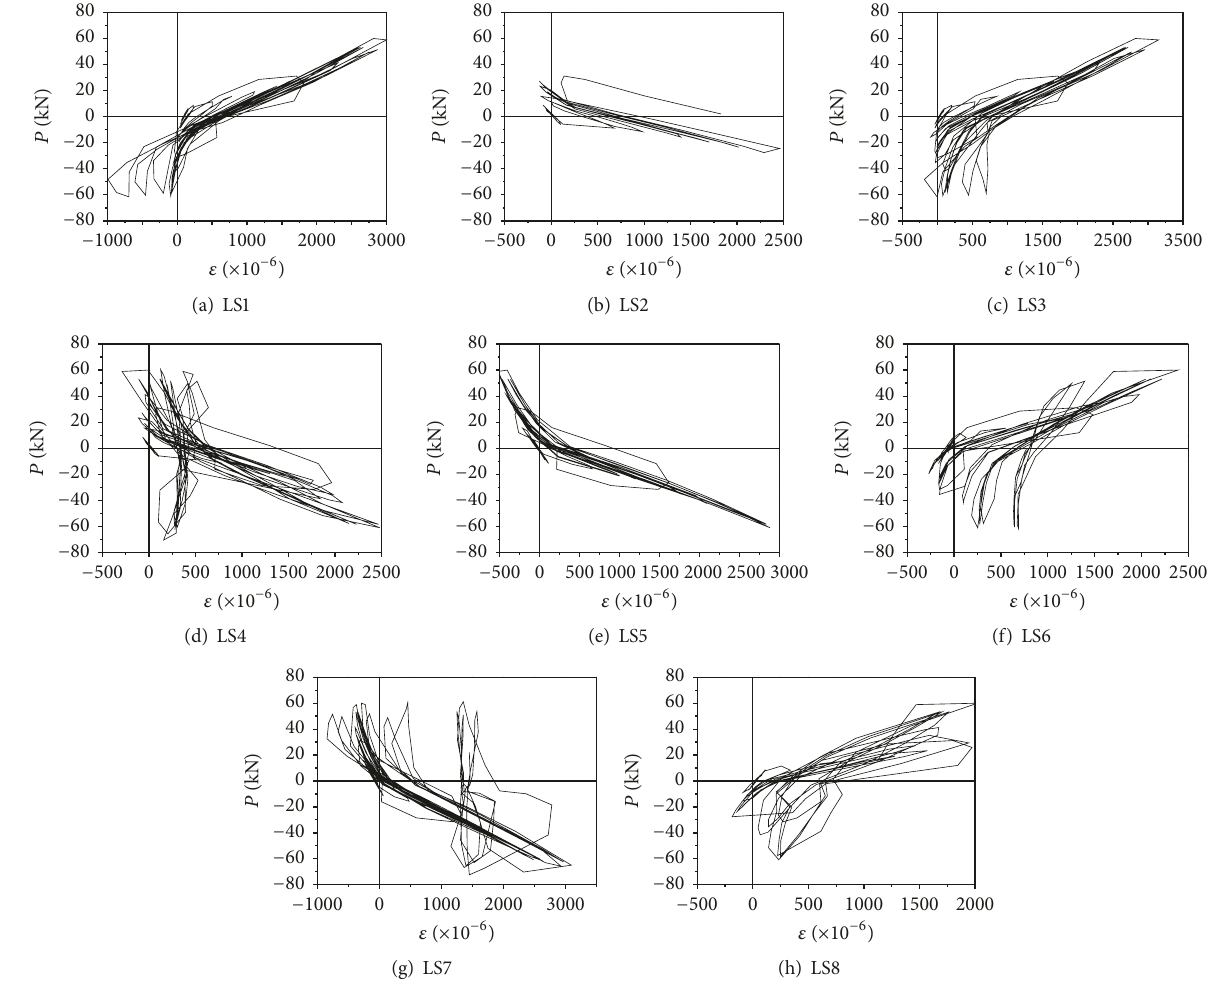
Figure 7: Load-strain hysteresis curve of specimen ZJ3 longitudinal steel